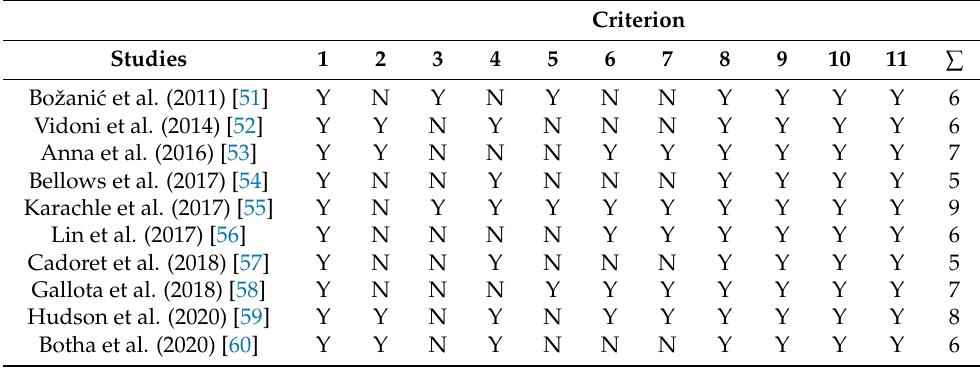
Table 2. PEDro scale for longitudinal